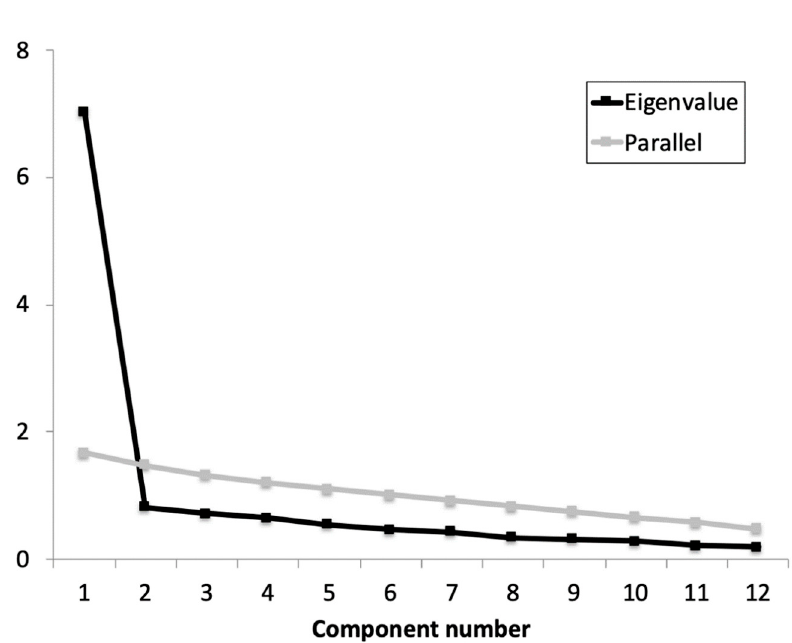
Figure 1. Parallel analysis and eigenvalue for each component of the iHOT-12Sv. Test–retest